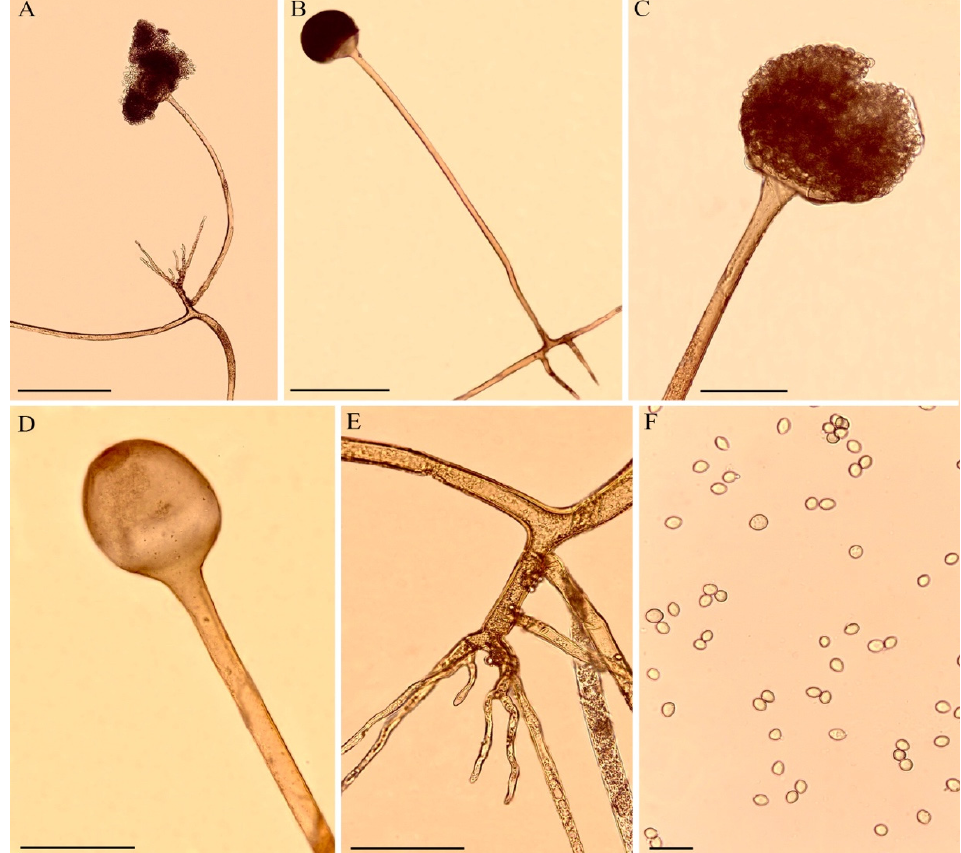
Figure 1. Morphology of R. arrhizus . ( A , B ). Sporangiophore with sporangium and rhizoid. ( C ). Sporangiophore with sporangium. ( D ). Sporangiophore with columella. ( E ). Rhizoid. ( F ). Sporangiospores. Scale bars: ( A , B ) = 100 μ m, ( C – E ) = 50 μ m, ( F ) = 20 μ m.